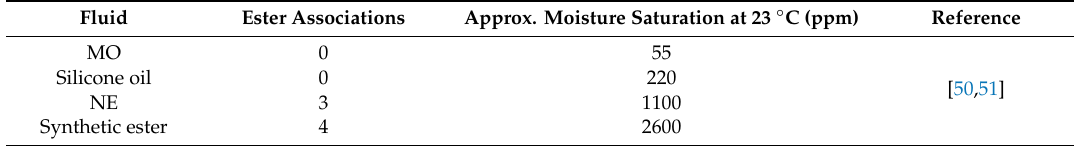
Table 13. Water solubility of di ff erent insulating fluids.